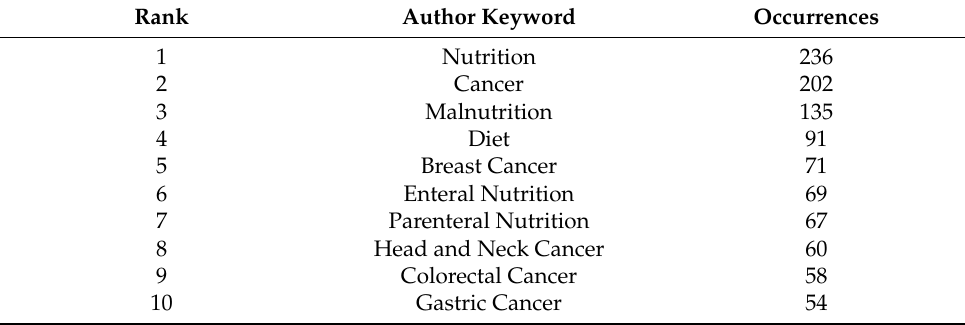
Table 3. Top 10 list of the author